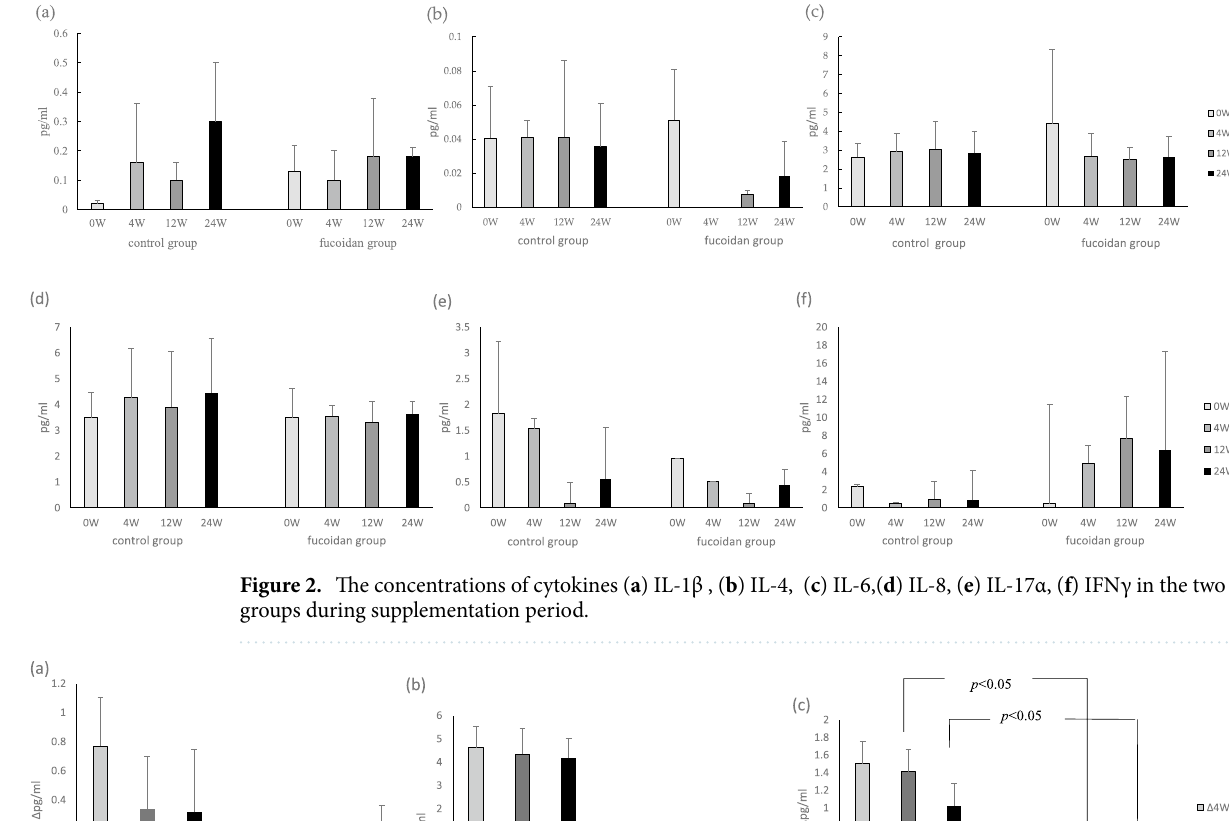
Figure 3. The changed concentrations of cytokines ( a ) IL-1β, ( b ) IL-6, ( c ) IL-8, in the two groups during supplementation